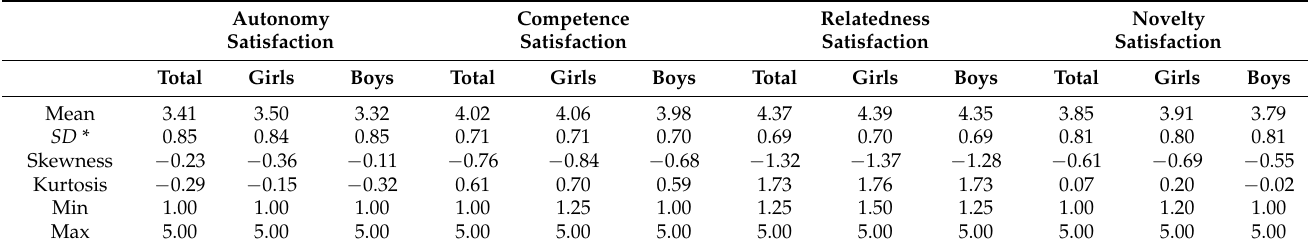
Table 2. Descriptive statistics of total sample ( n = 1344), girls ( n = 652), and boys ( n = 692).